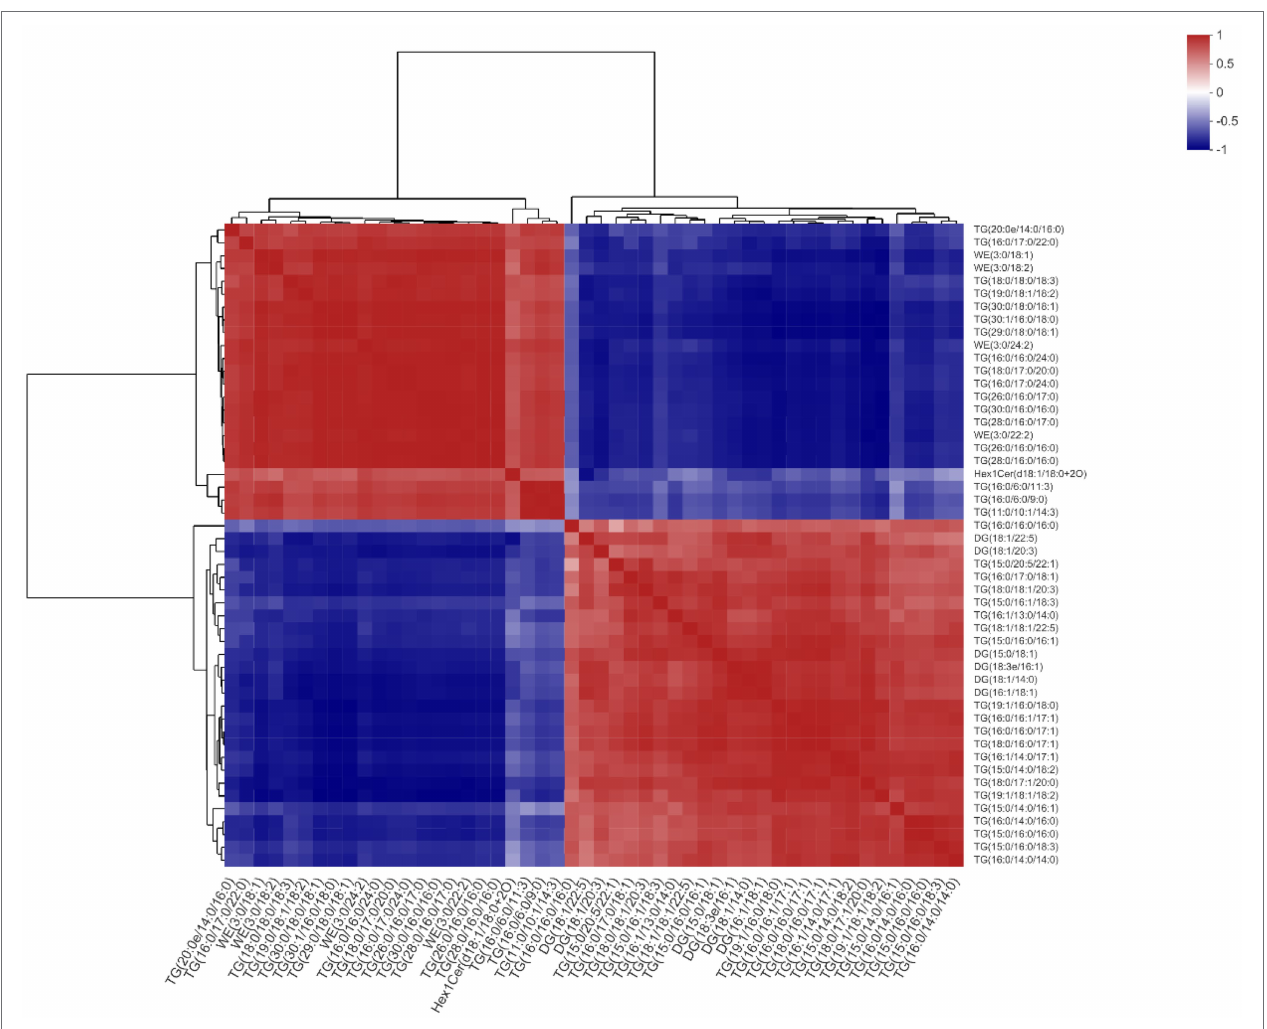
FIGURE 10 | Effects of methionine restriction on the correlations between lipids after feeding for 8 weeks ( n =